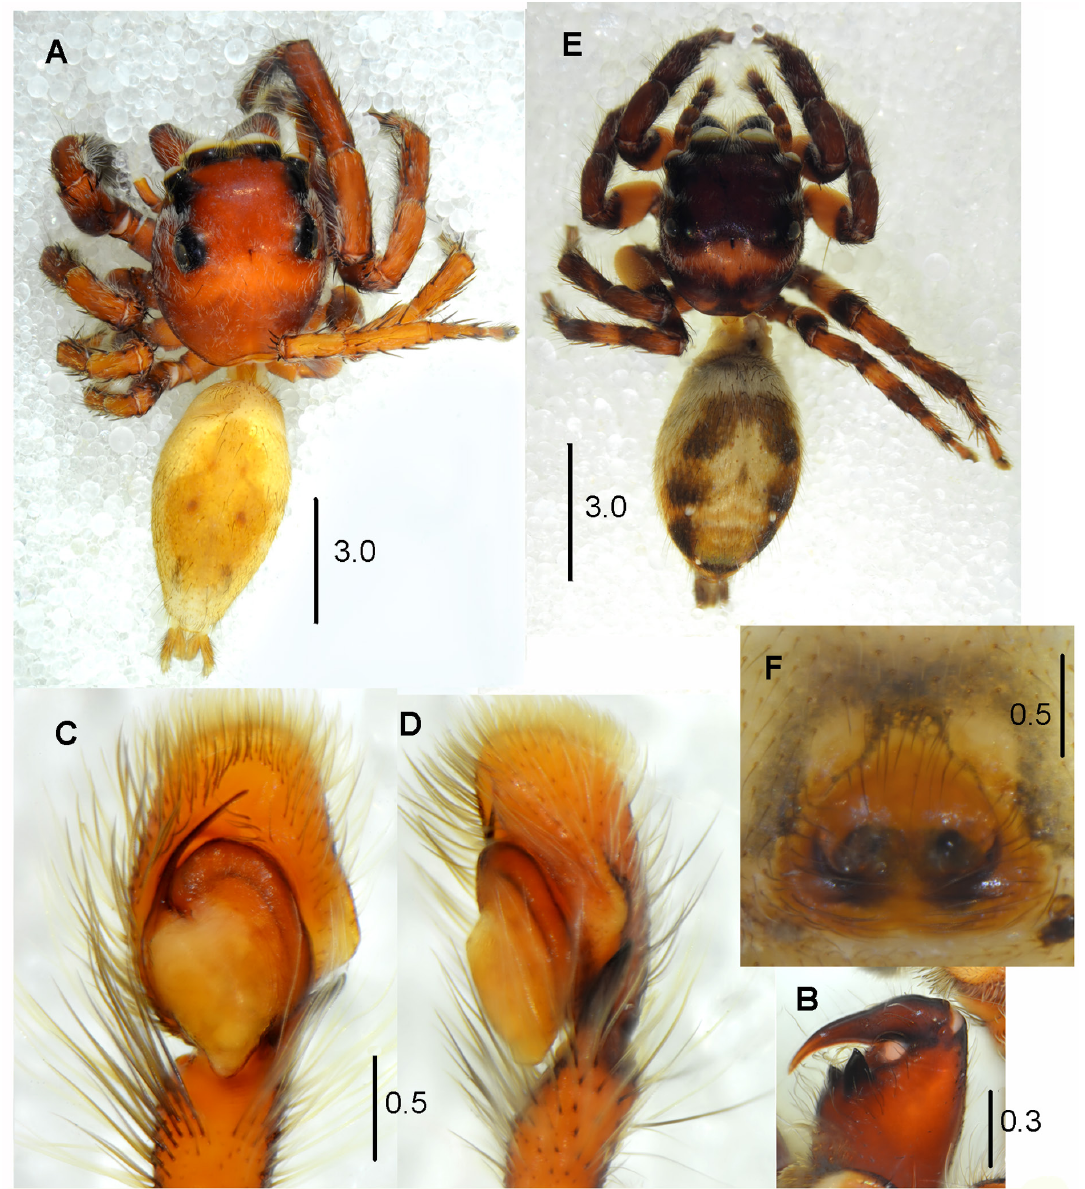
Fig. 24. Hyllus tuberculatus Wanless & Clark, 1975, ♂♀ (MNHN). A . Habitus of male, dorsal view. B . Male chelicera. C . Palpal organ, ventral view. D . Palpal organ, ventrolateral view. E . Habitus of female, dorsal view. F .